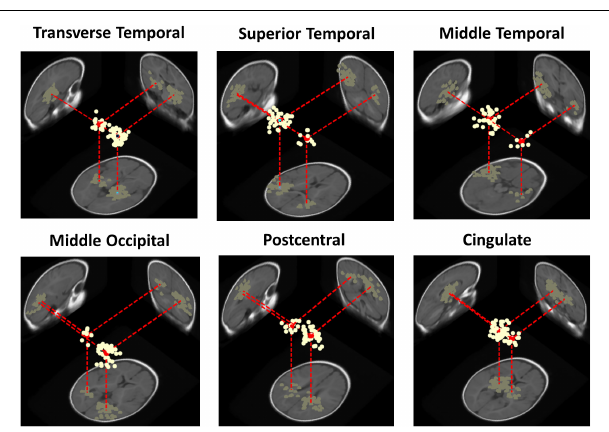
FIGURE 4 | Three-dimensional equivalent dipole models of ICs in the bilateral infant clusters. Dipole projections are shown in the sagittal, coronal, and transverse planes of the MNI infant template brain model. Cluster dipole centroids are shown in